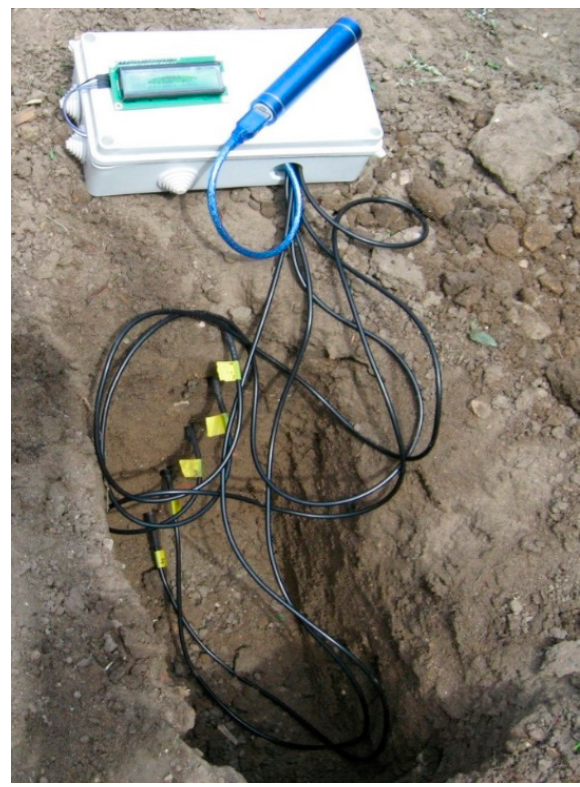
Figure 2. Soil temperature measurement sensors placed at different depths.